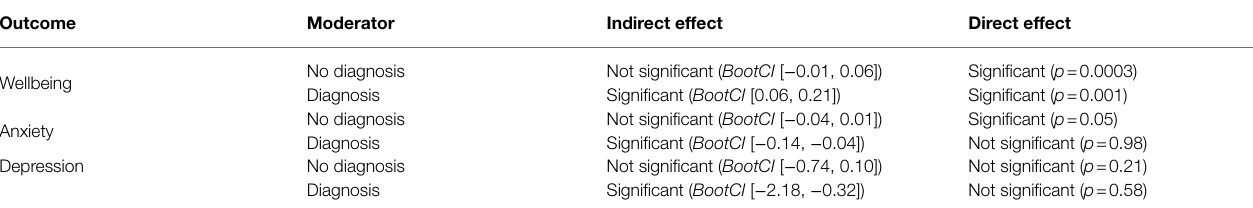
TABLE 4 | Summary of moderated mediation analyses: Indirect and direct effects of gratitude on outcomes mediated by acceptance of illness and moderated by